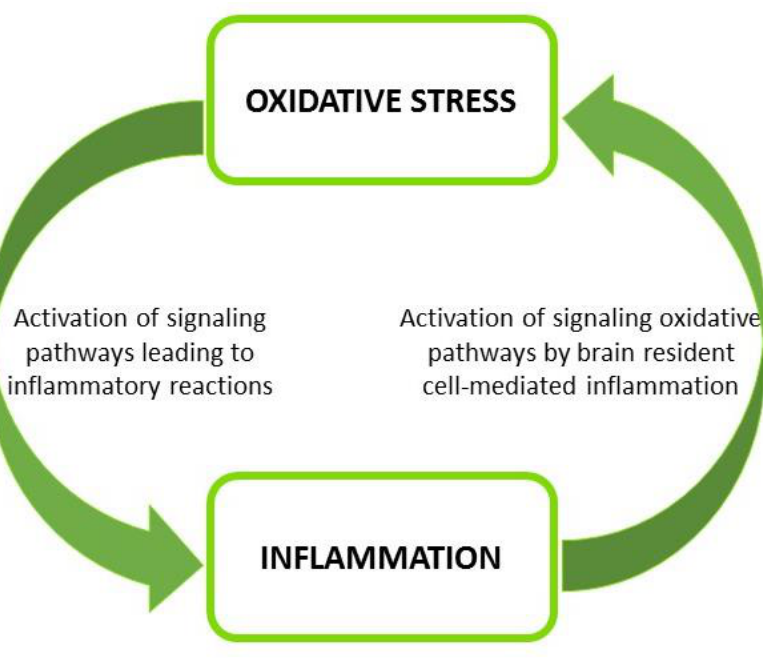
Figure 2. Cross-talk between oxidative stress and inflammation.